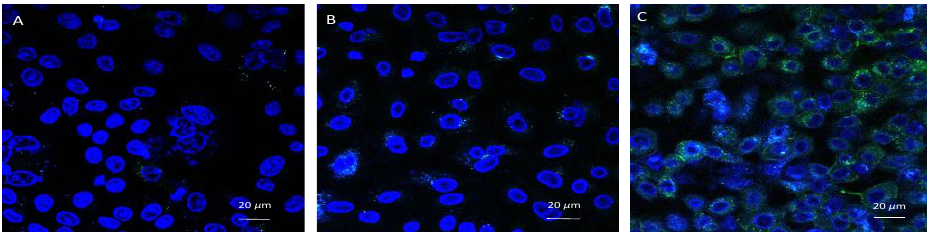
Figure 6. Confocal microscopic image (400Å ~) of ( A ) uninfected Vero cells; ( B ) 12 h post-infection observation of EGCG-S-treated HSV-2 in Vero cells; and ( C ) 12 h post-infection observation of non- treated HSV-2 in Vero cells.